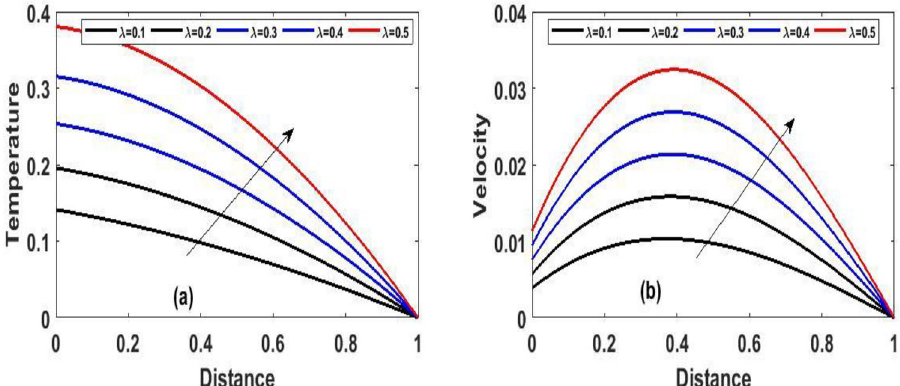
Figure 2. The effect of variation of ( (cid:31) ) for Temperature and velocity steady state.